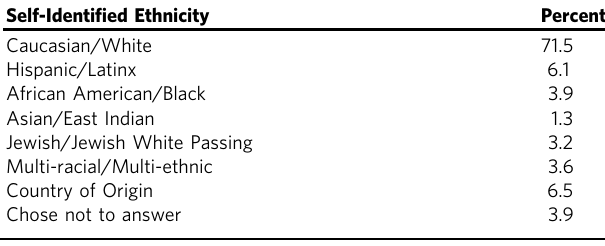
Table 1 Self-reported ethnic identities of participants.